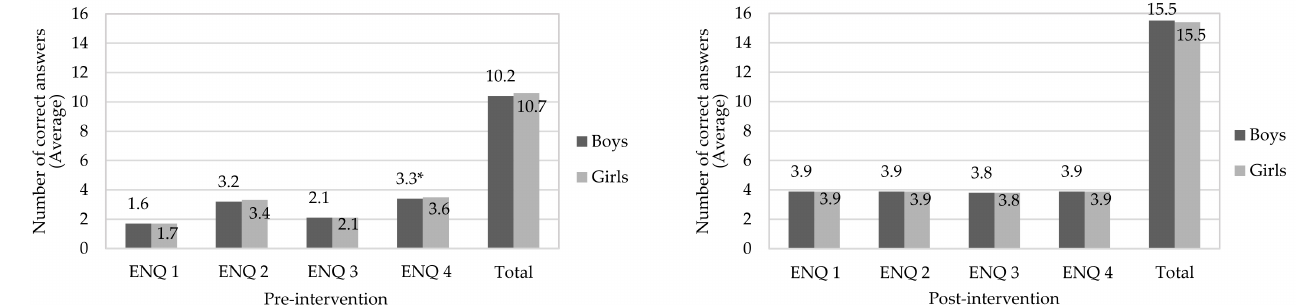
Figure 6. Average of correct answers to questions about eating and nutrition knowledge in the pre- and post-intervention stages, compared between genders. * Means indicate significant difference by Student’s t test ( p -value < 0.05) in the same question. Eating and Nutrition Questions (ENQ): ENQ 1—“Which foods have more carbohydrate?”; ENQ 2—“Which foods have enough vitamins and minerals?”; ENQ 3—“Which foods have more protein?”; ENQ 4—“Which foods have a lot of sugar and/or fat?”; Each question contained 4 correct answers; for total there were 16 correct answers.